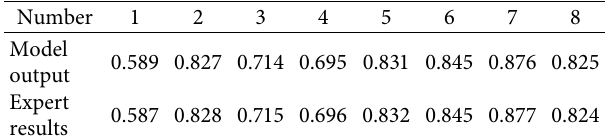
Table 1: Experimental comparison between model output and expert evaluation results.